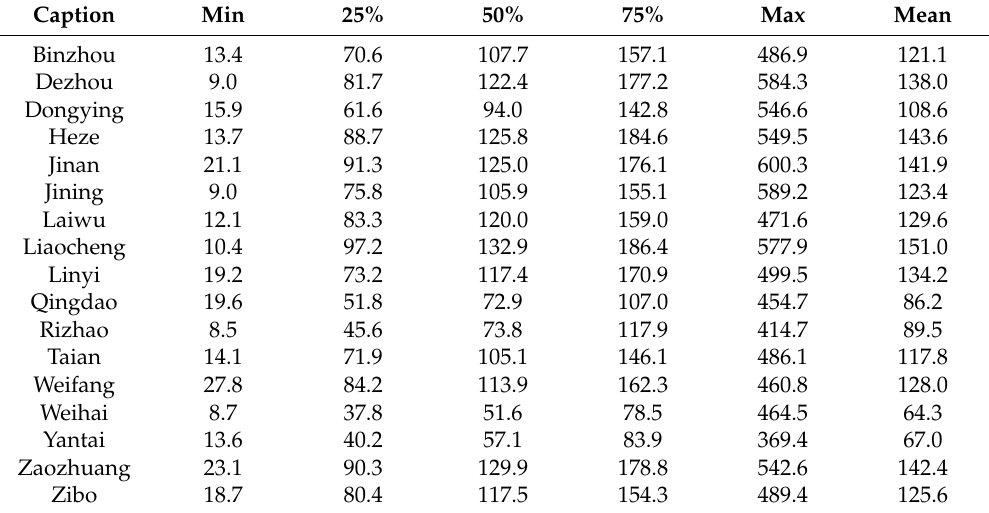
Table A3. Descriptive statistics of the daily mean SO 2 levels ( µ g/m 3 ) in the 17 cities of the